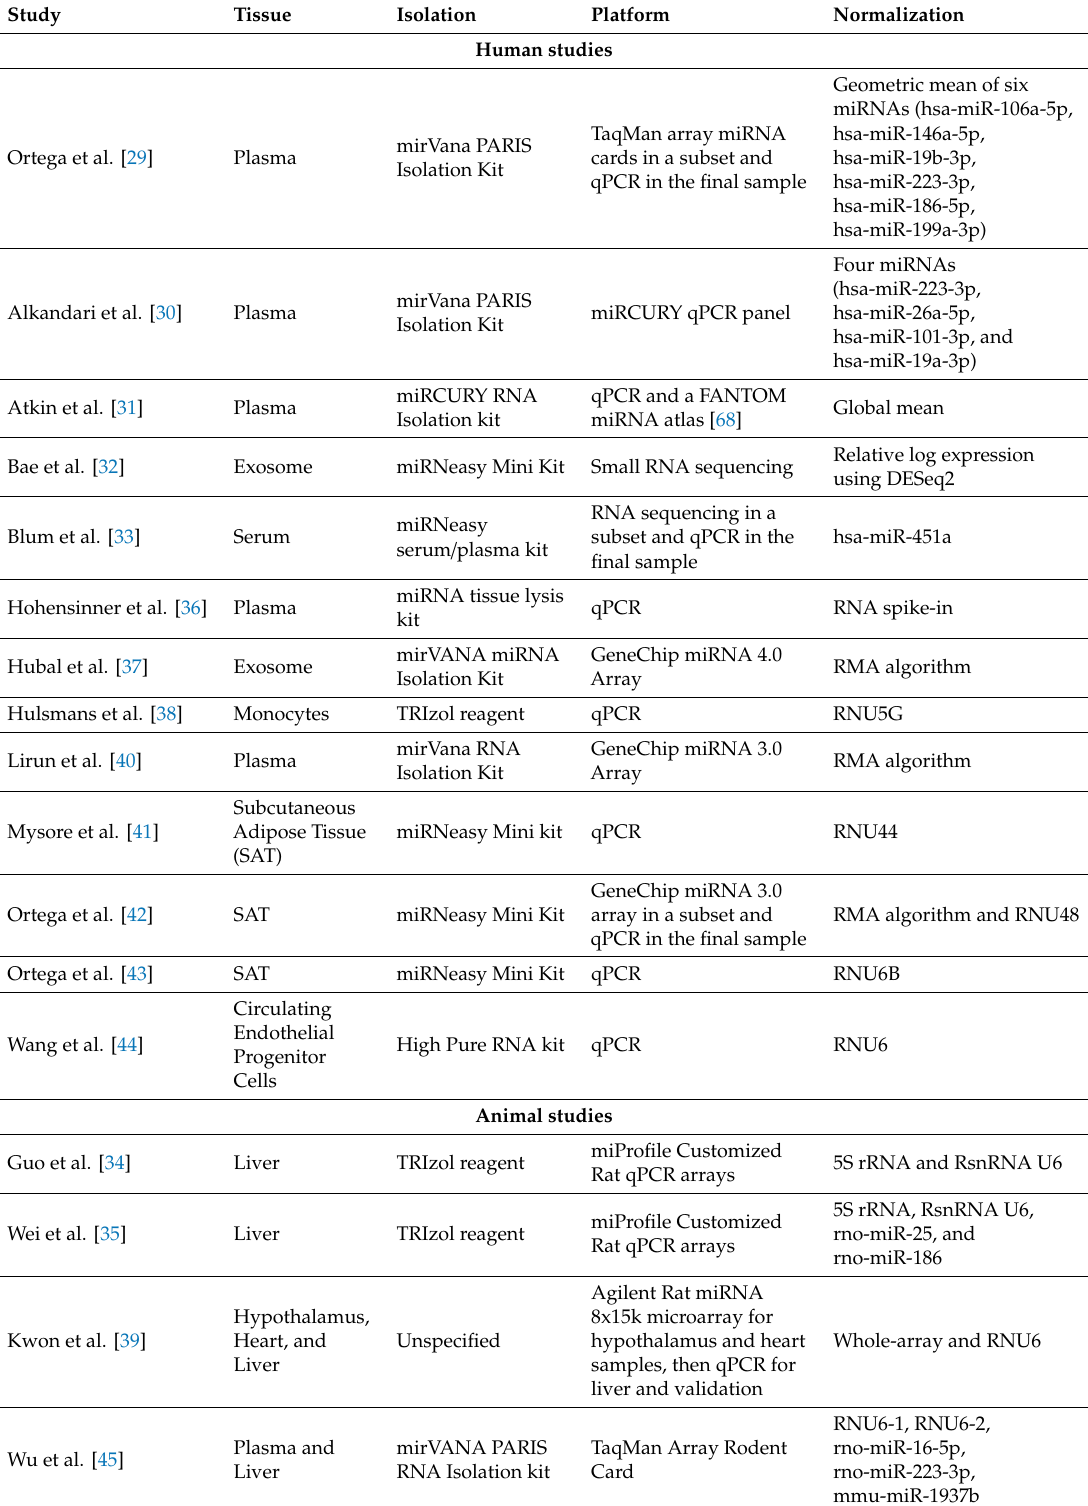
Table 2. Tissue source and miRNA profiling